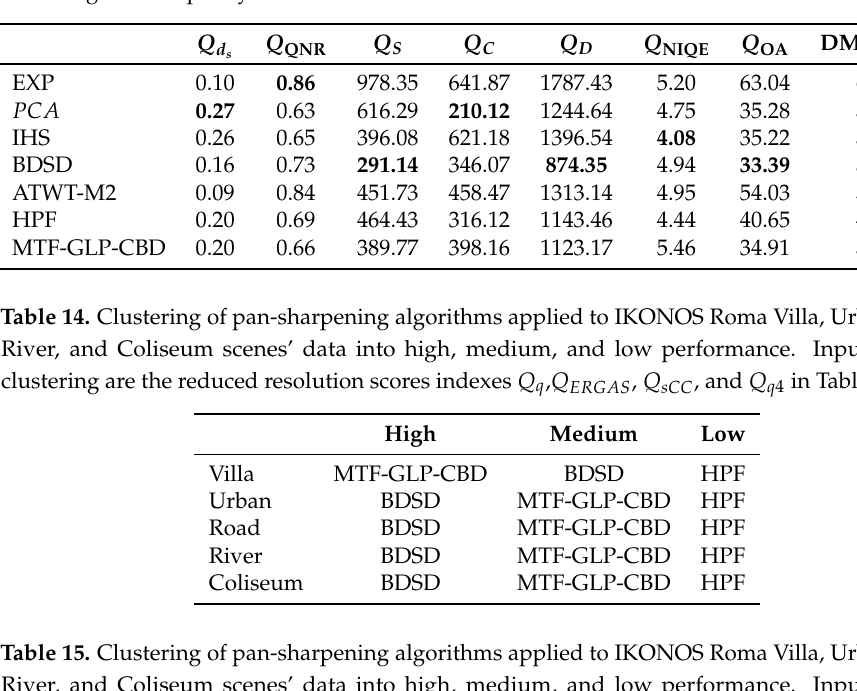
Table 13. IKONOS Roma Coliseum scene, full-resolution, image quality assessment metrics, and DMOS GM quantitative results. The bold number indicates the best performing PS method according to each quality metric.